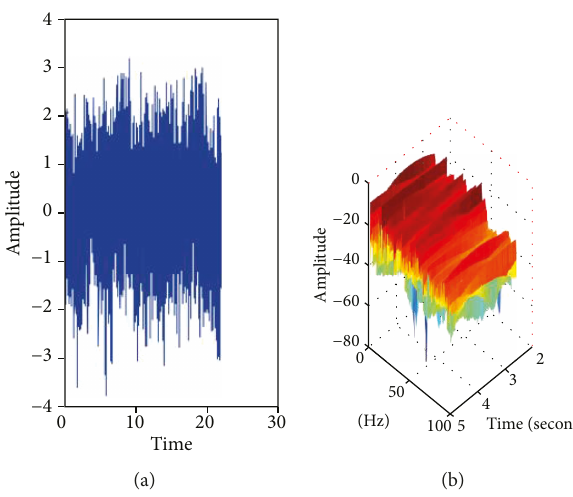
Figure 3: Signal time series without fl utter (a) and STFT (b).